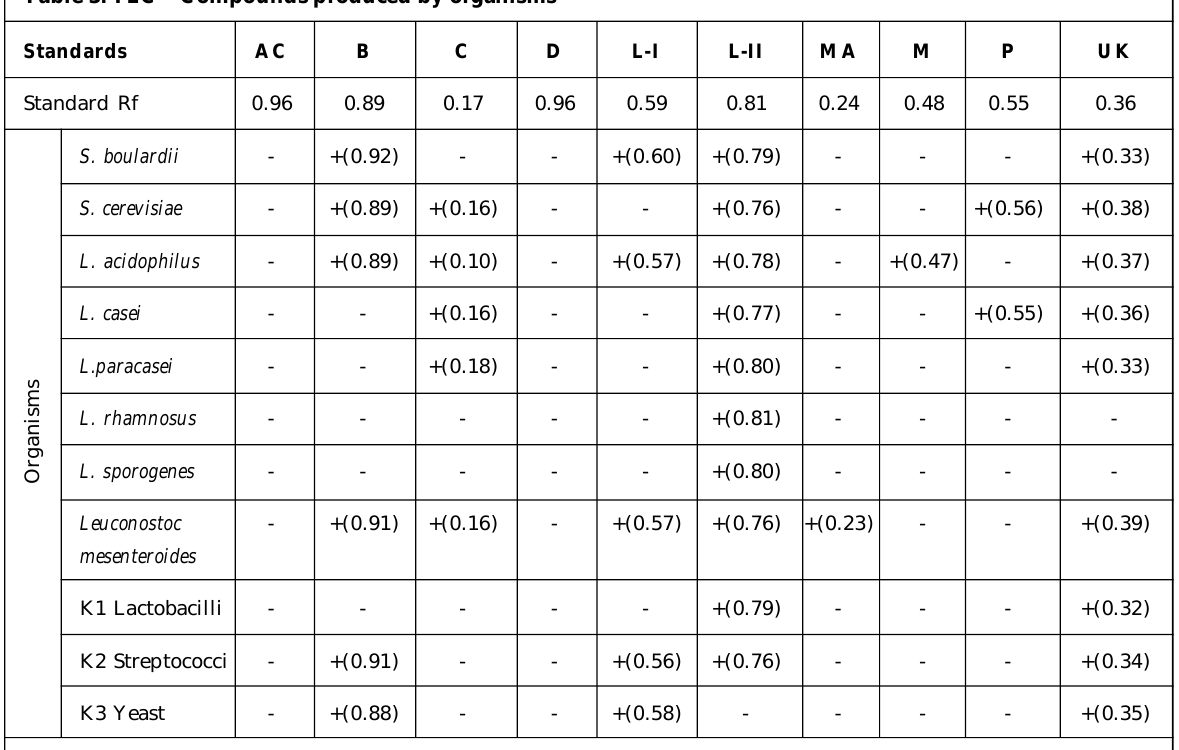
Table 3: TLC – Compounds produced by organisms Standards